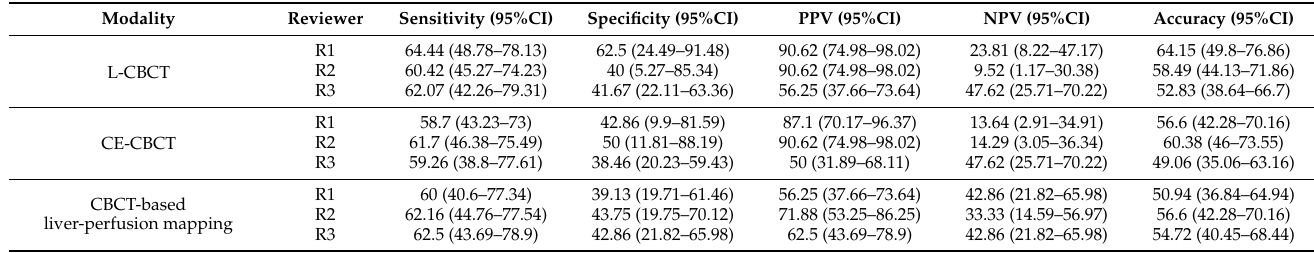
Table 4. Diagnostic performance of treatment response evaluation on different imaging modalities after transarterial chemoembolization for hepatocellular carcinoma for complete response and partial response.